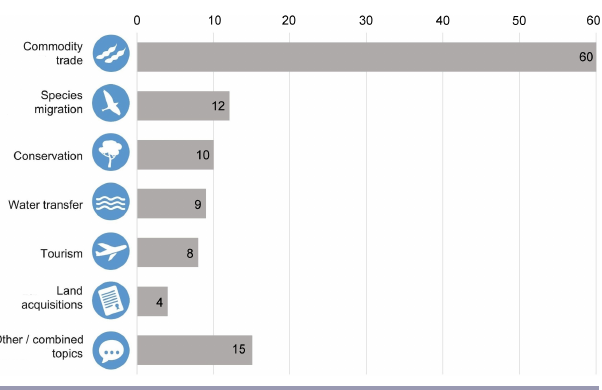
Fig. 4 . Telecoupling topics addressed in the selected 118 cases (by number of